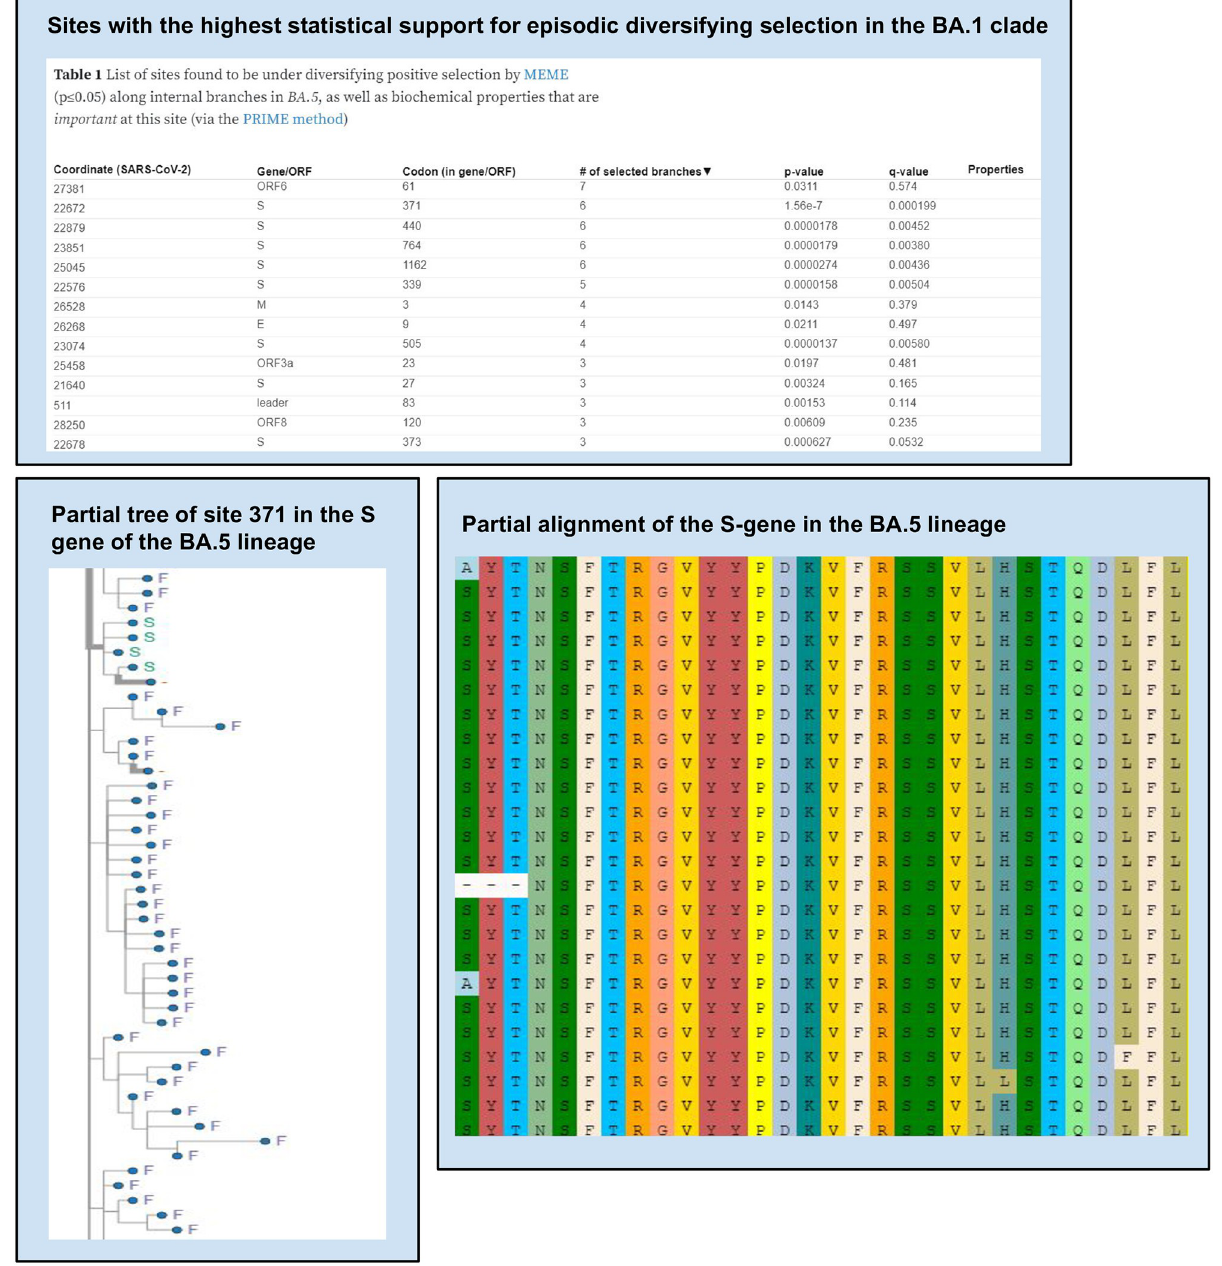
Fig 2. Example visualization using our interactive notebook. Here, we highlight some of the features of our interactive notebook which was created to facilitate result exploration. Key features include: (1) tables with statistically significant results for each selection analysis, (2) the ability to explore the full phylogenetic tree or a site-level tree to explore selection acting on individual sites and (3) we provide a multiple sequence alignment viewer for any of the genes in the